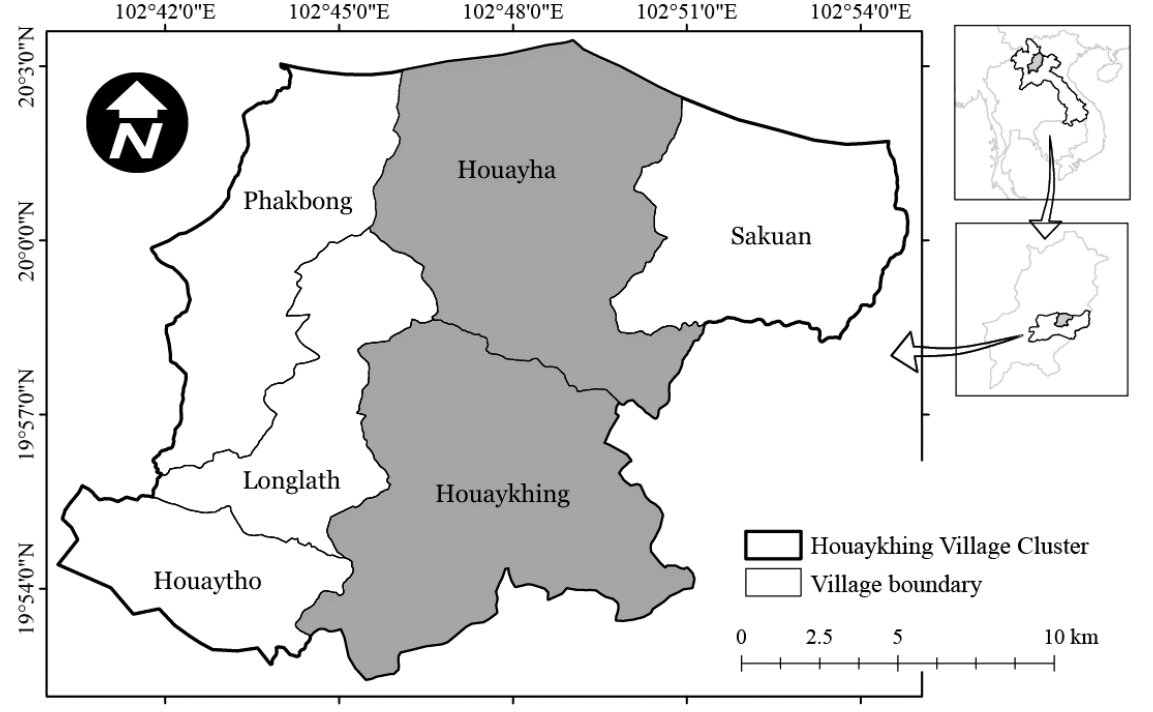
Figure 1. Location of the villages of Houaykhing and Houayha, within the Houaykhing Village Cluster in Phonxay district, Luang Prabang Province of Lao People’s Democratic Republic.